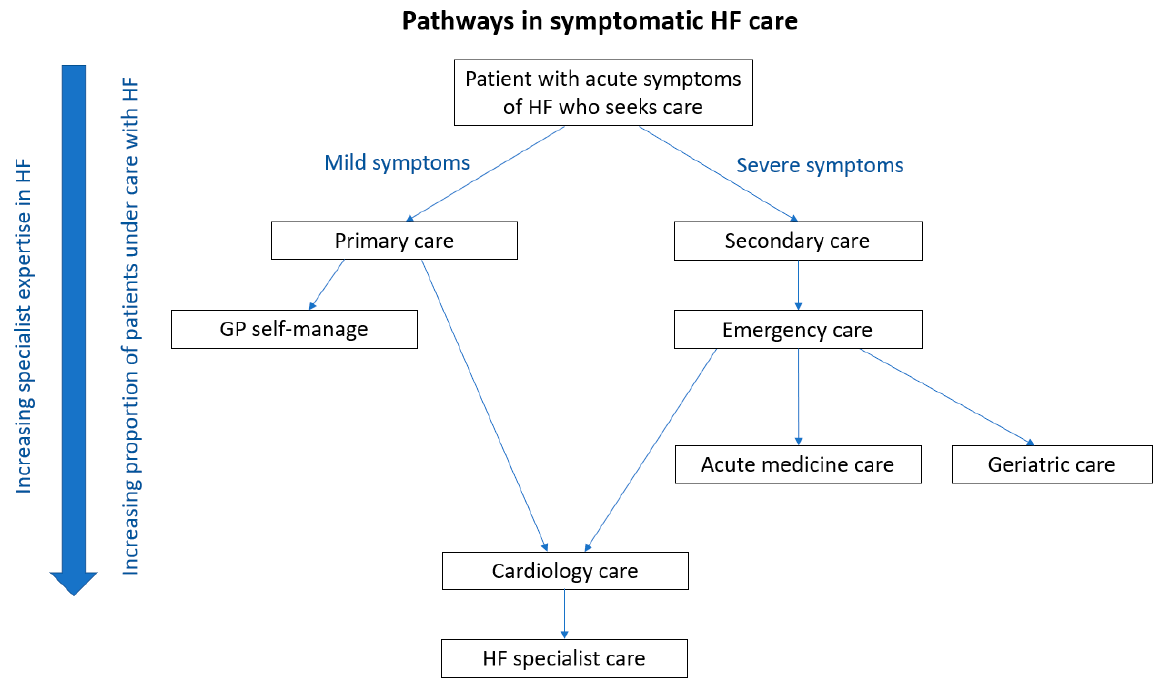
Figure 2. Pathways for care for patients with symptomatic heart failure.